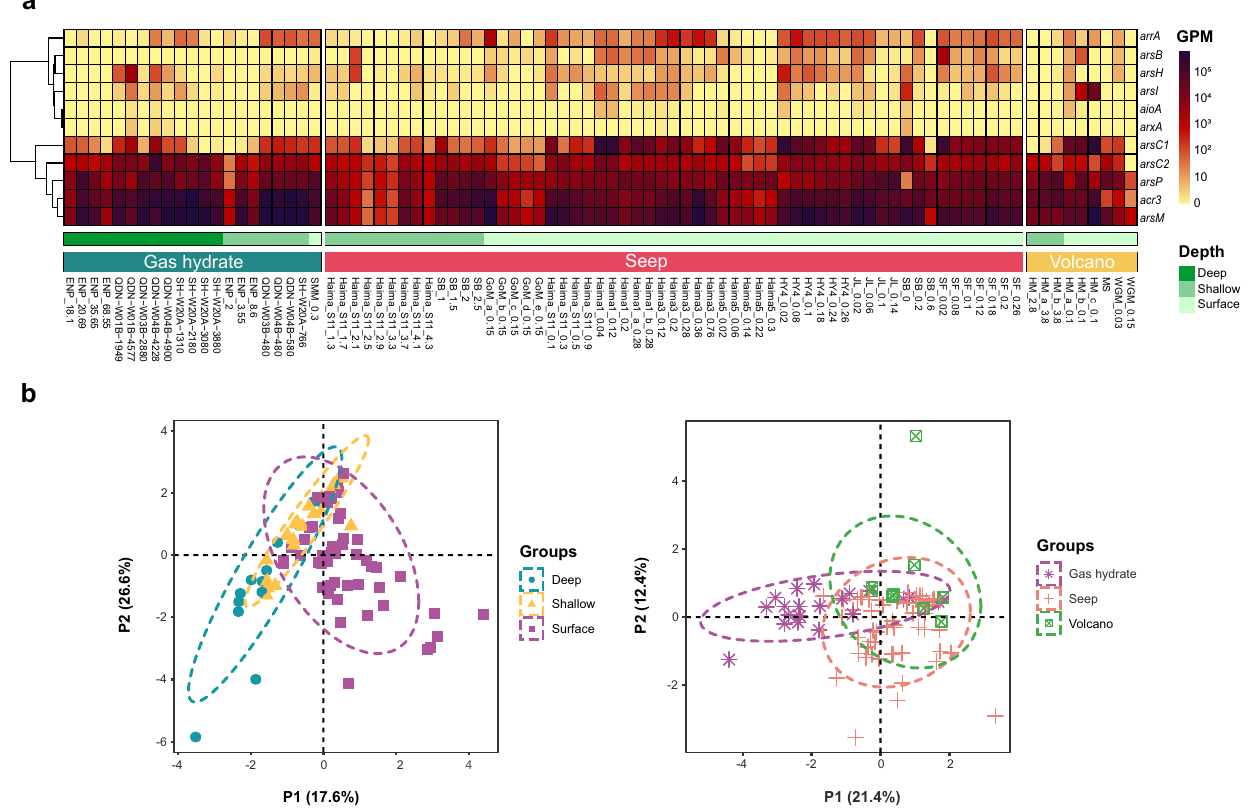
Fig. 2 The global distribution of potential genes involved in As cycling at cold seeps. a The abundances of As cycling genes across the 87 cold seep metagenomes. The abundance of each gene was normalized by the gene length and sequencing depth and represented as GPM (genes per million) values. b The partial least squares discrimination analysis (PLS-DA) plots based on the abundances of As-cycling genes ( n = 87). Similarity values among the samples of different sediment depths and types of cold seep were examined using a 999-permutation PERMANOVA test. Source data is available in Supplementary Data